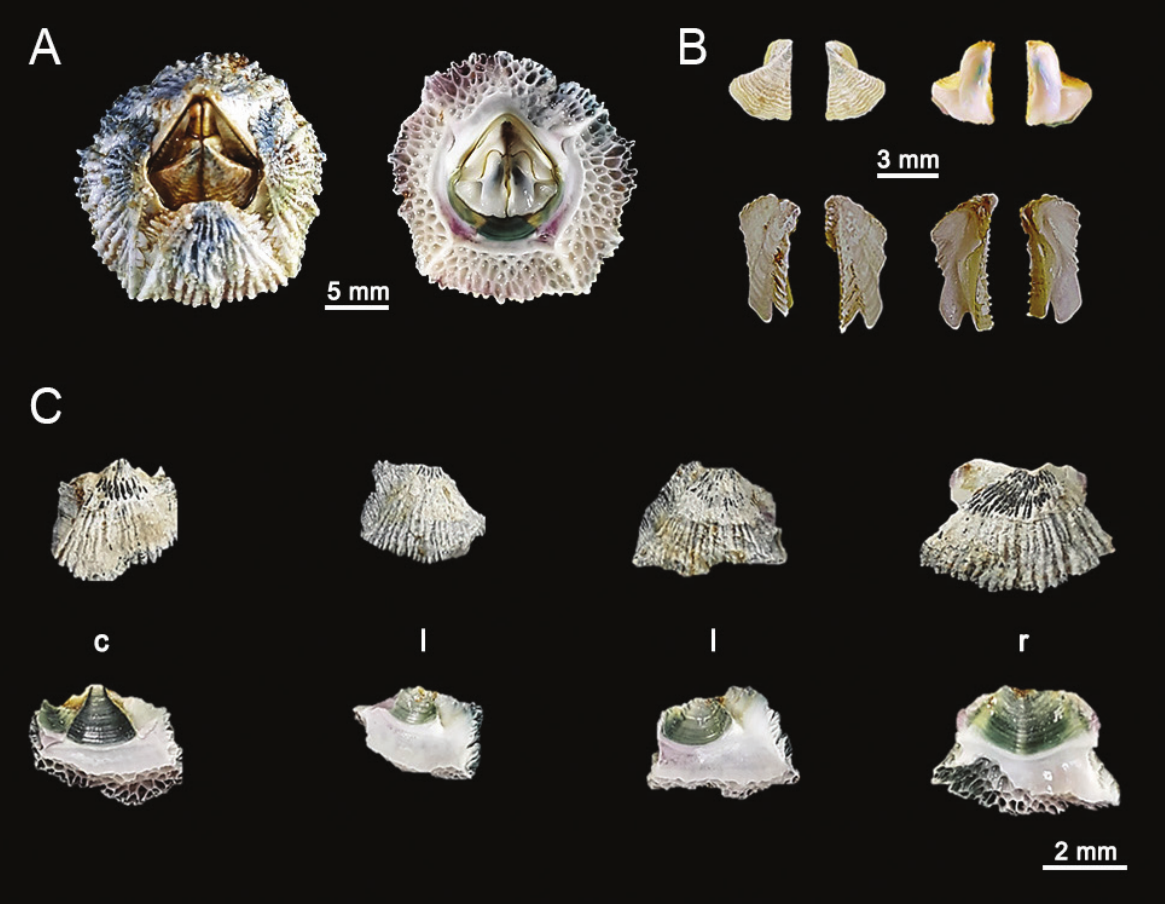
Figure 5. Newmanella spinosus collected from Na Tai beach, Phang-nga (BUU16.TC.NS01). A . Dorsal and ventral view of external shell, B. External (left panel) and internal (right panel) view of tergum (upper panel) and scutum (lower panel), C. External (upper panel) and internal (lower panel) view of shell plates. Abbreviations: c, carina; l, latus; r,